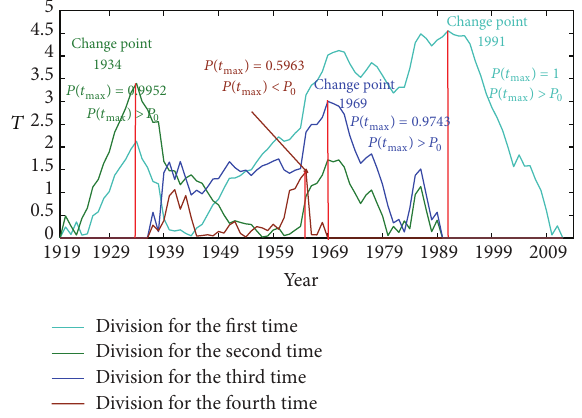
Figure 4: Segmentations and change points of annual runoff at Huaxian